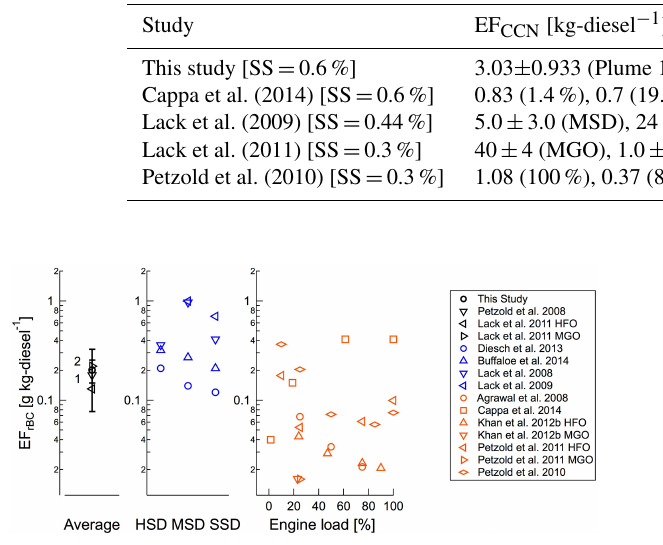
Figure 16. Emission factors for cloud condensation nuclei; fuel type (HFO: heavy fuel oil with high sulfur content, and MGO: ma- rine gas oil with low sulfur content), or vessel class based on gross metric tonnage (HSD: high speed diesel < 5000t, MSD: medium speed diesel 5000–30000t, or SSD: slow speed diesel > 50000t); plumes 1, 2, and 3 are indicated on the plot with numbers 1, 2, and 3 and the estimated uncertainty is shown by error